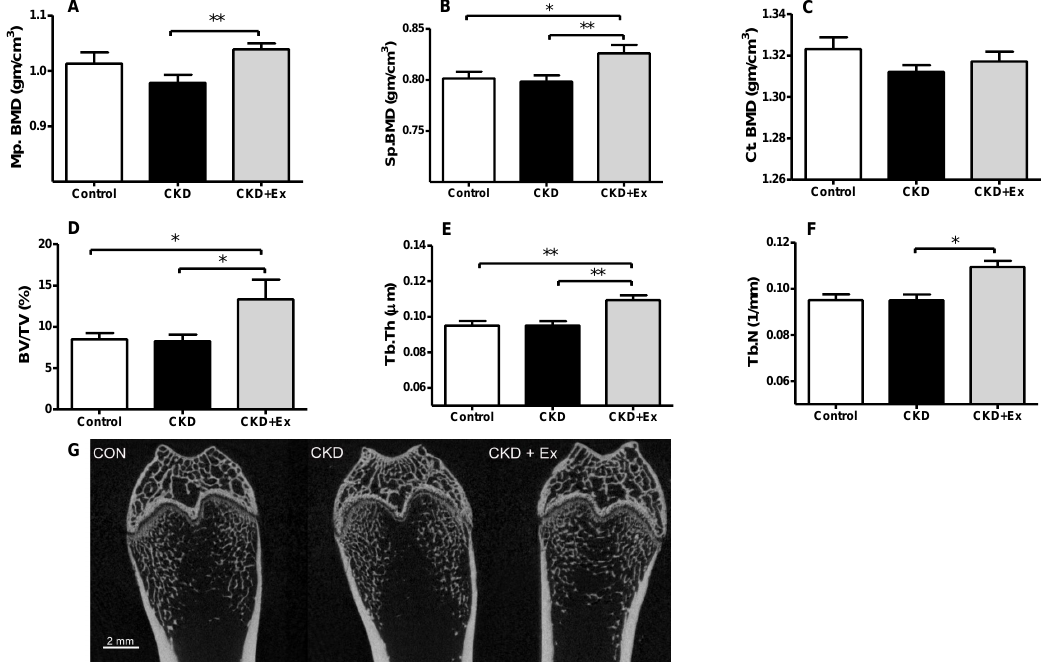
Figure 3. Bone mineral density (BMD) and bone microarchitecture parameters. Distal femoral metaphysis (Mp.) and L5 vertebrate (Sp.) bone mineral density was significantly higher in rats from the CKD + exercise group than in rats from the CKD group ( A , B ). Cortical bone density did not show significant di ff erences between the groups ( C ). Trabecular bone volume (BV / TV), trabecular thickness (Tb.Th), and trabecular number (Tb.N) were significantly higher in rats from the CKD + exercise group ( D – F ), relative to those from the CKD group. Micro-CT scanning demonstrated that the trabecular bone in rats from the CKD group was looser than that in rats from the CKD + exercise group ( G ). N = 8, 13, and 9 in the control, CKD, and CKD + exercise groups, respectively. Values are represented as mean ± SEM. * p < 0.05, ** p < 0.01. Scale bar = 2